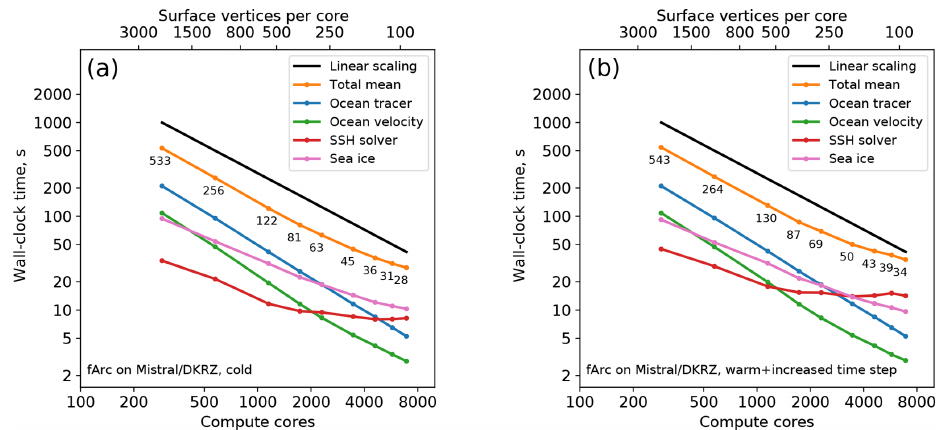
Figure B1. Scaling results for the fArc mesh on Mistral (DKRZ Hamburg) for cold start (a) and warm start with increased time step (b) experiments. The black line indicates linear scaling, the orange line (and the number labels) gives the mean total computing time over the parallel partitions.